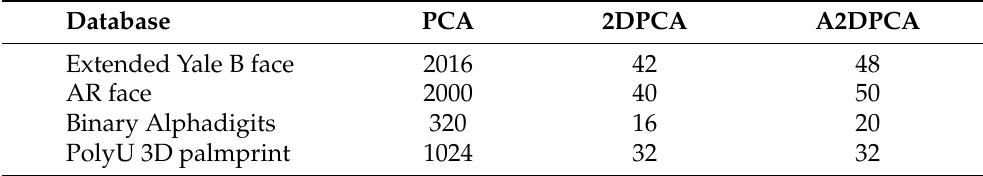
Table 3. The maximal number of principal components extracted by different algorithms.